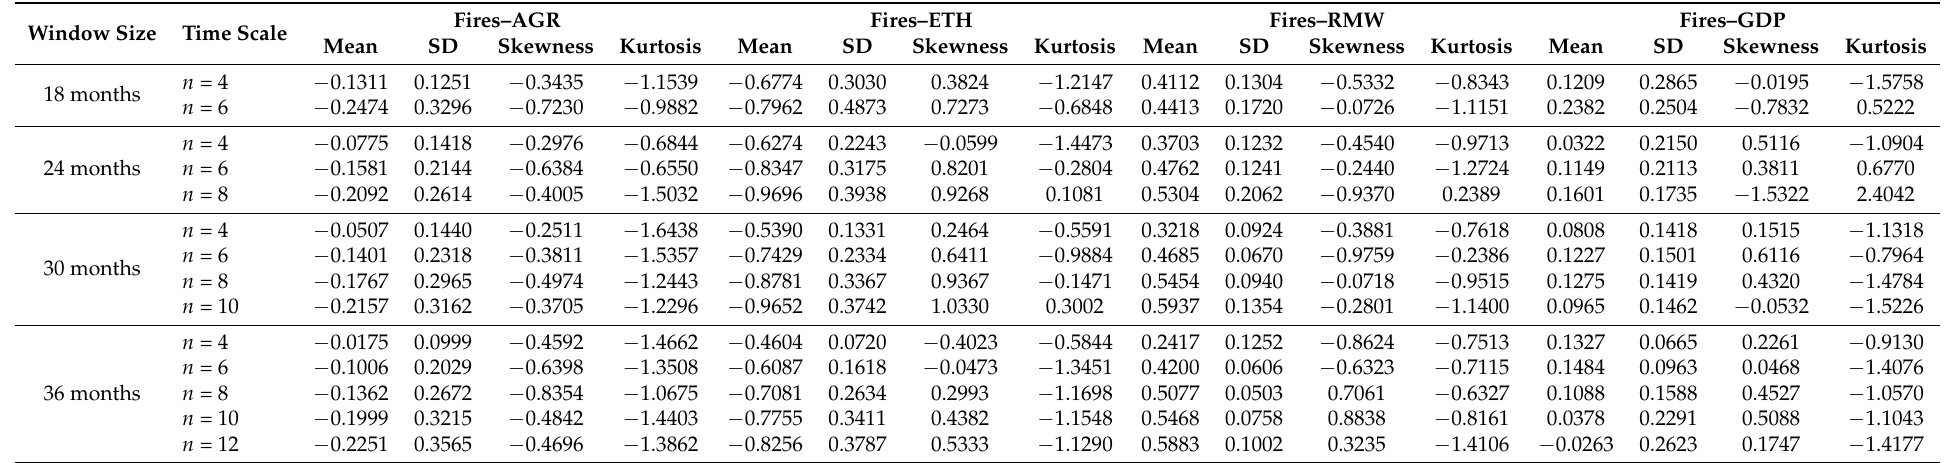
Table 3. The descriptive summary of ∆ ρ DCCA for W1 to